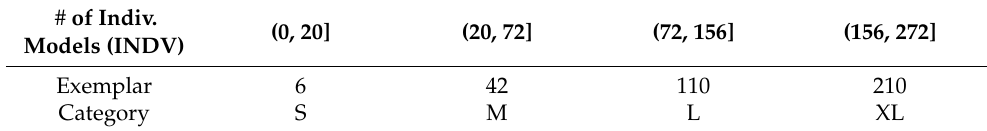
Table 3. Categories of INDV parameter (number of individual members in a